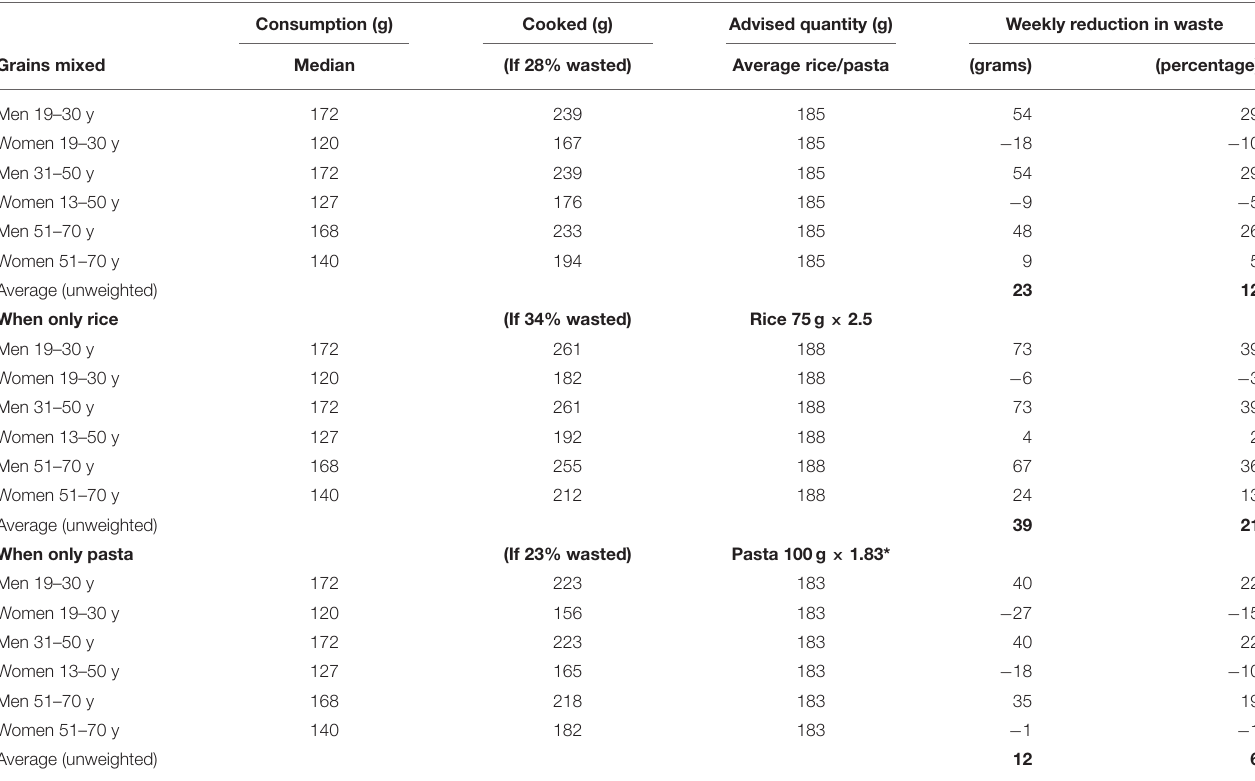
TABLE 3 | Theoretical reduction of rice and pasta waste by using the Eetmaatje measuring cup on consumption days. Consumption (g) Cooked (g) Advised quantity (g) Weekly reduction in waste Grains mixed Median (If 28% wasted) Average rice/pasta